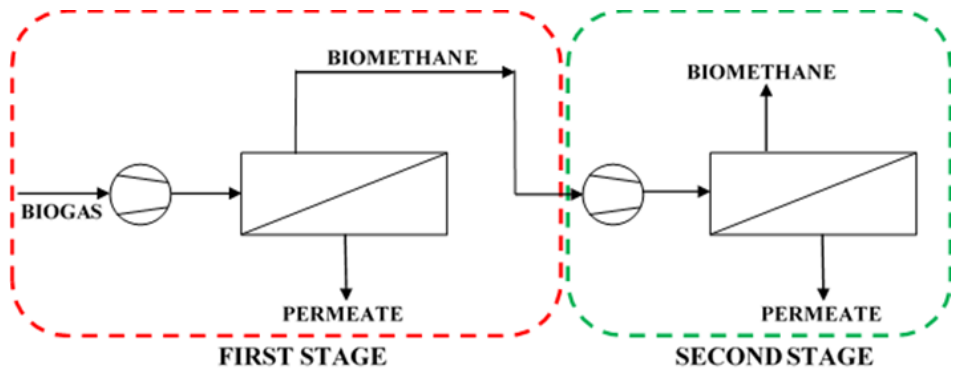
Figure 6. Scheme of the membrane biogas upgrading process.